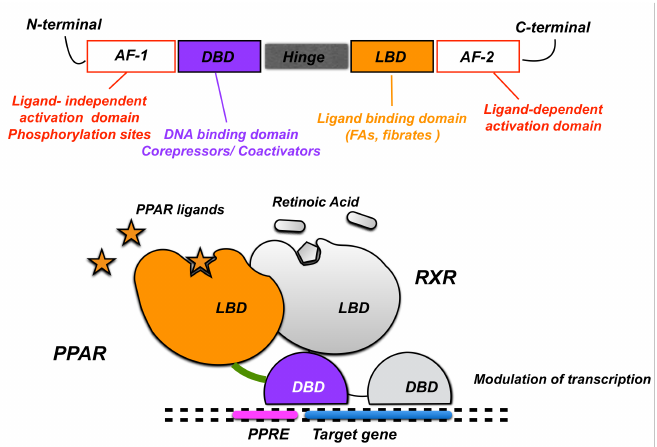
Figure 1. Gene structure of PPAR and regulation of